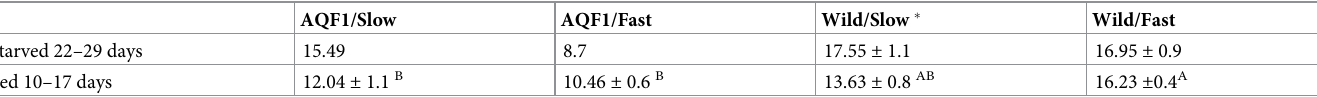
Table 1. Growth rate ( μ m/day ± SE) during the linear growth phase for fed (age 10–17 days) and starved-recovering (age 22–29 days) larvae. AQF1 starved cohorts were not included in the statistical analysis due to high mortality and a lack of replication (one pooled replicate per cohort) during the recovery period. Superscript letters indicate significant differences between cohorts within each treatment and asterisks ( � ) indicate significance between treatments within each cohort (Tukey’s HSD p <